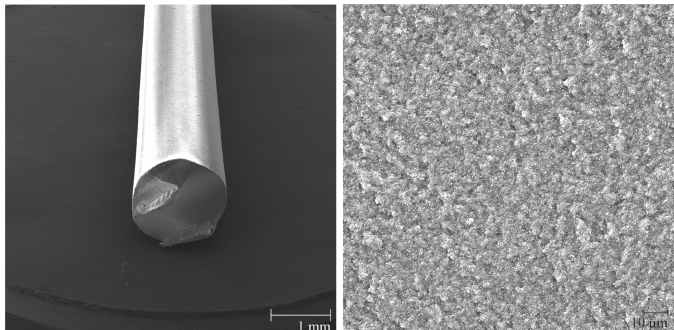
Figure 2. SEM view of the alumina filament and its